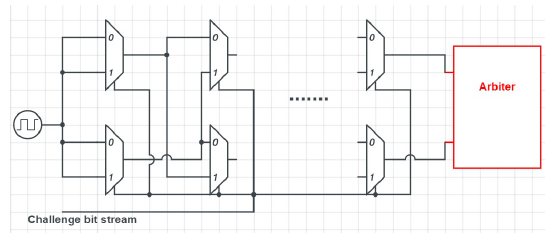
Figure 4. Arbiter PUF architecture. Adapted from [38].